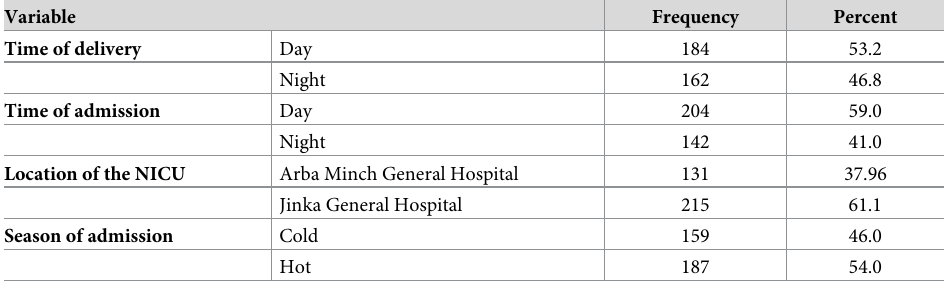
Table 3. Environmental conditions during the time of admission of the neonates to the NICUs of Arba Minch and Jinka General Hospitals, Southwest Ethiopia, 2017 (n = 346).